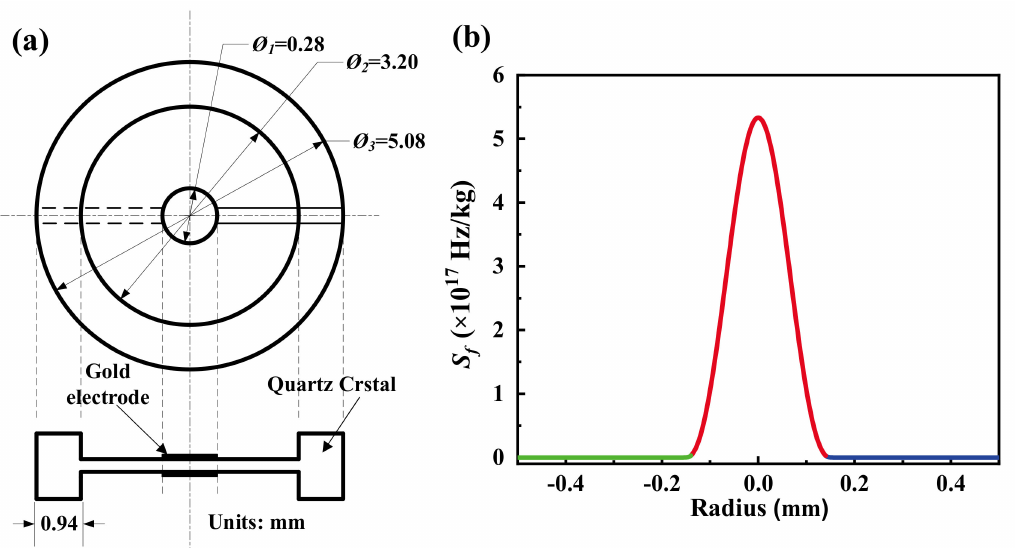
Figure 10. ( a ) The size details of quartz wafer ( ∅ 1 , ∅ 2 , and ∅ 3 are the diameters of the electrode, the etched area, and the quartz crystal plate) and ( b ) mass sensitivity distribution of QCM with a fundamental resonance frequency of 210 MHz based on the inverted mesa structure